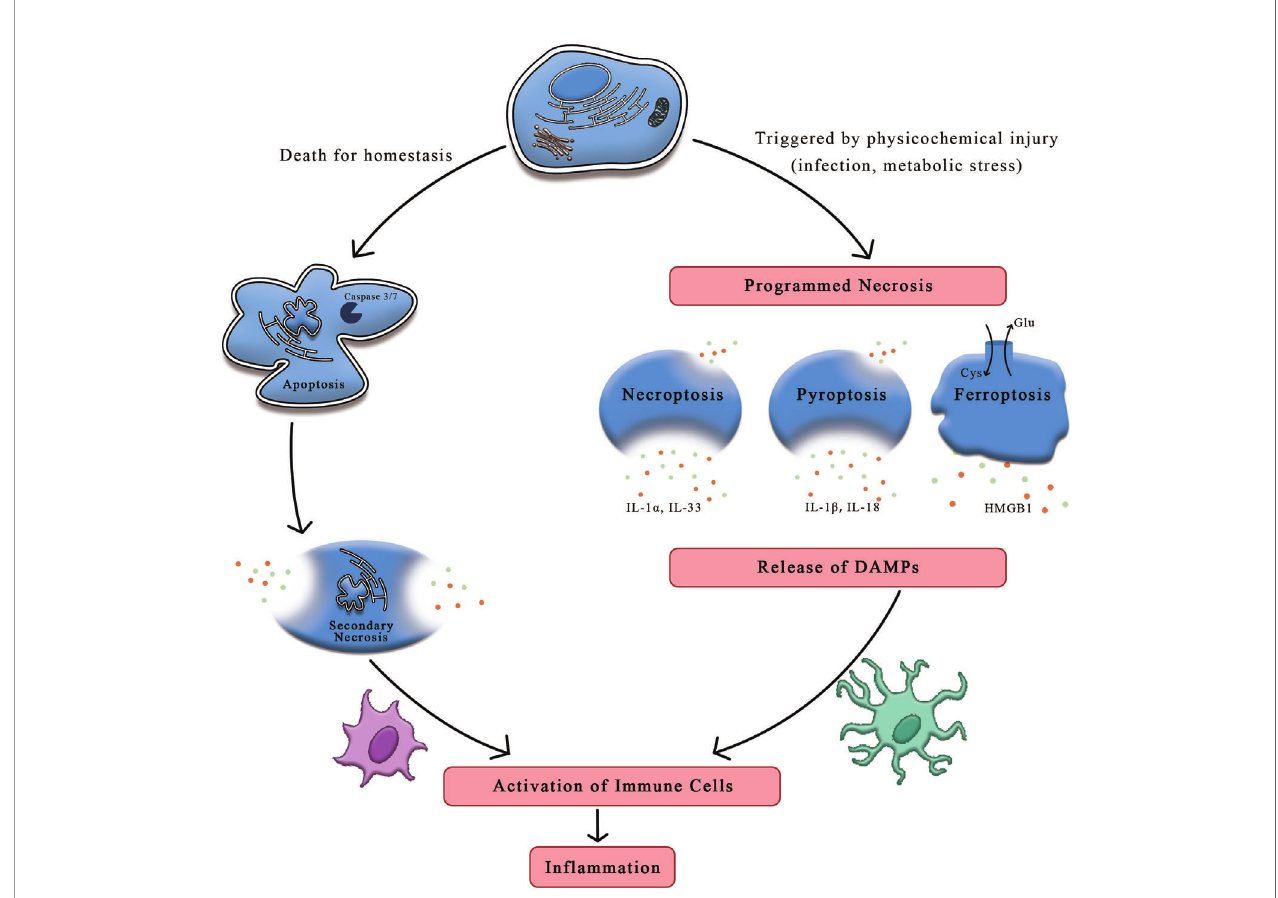
FIGURE 1 | The distinctions between apoptosis and necrosis. On account of the stimuli and context, cells can undergo apoptosis and necrosis. Apoptosis is thought to be programmed cell death relating to homeostasis while necrosis is induced by mechanical shear stress or other physicochemical factors including infection and oxidation, etc. Upon the stimulation of damaged signals, cells trigger programmed necrosis, such as necroptosis, pyroptosis and ferroptosis. Cells suffering from stress may release immunogenic molecules called DAMPs, which could initiate the systematic immune response against detrimental substances, ultimately leading to in fl ammation. HMGB1, high mobility group box-1 protein; DAMPs, danger-associated molecular